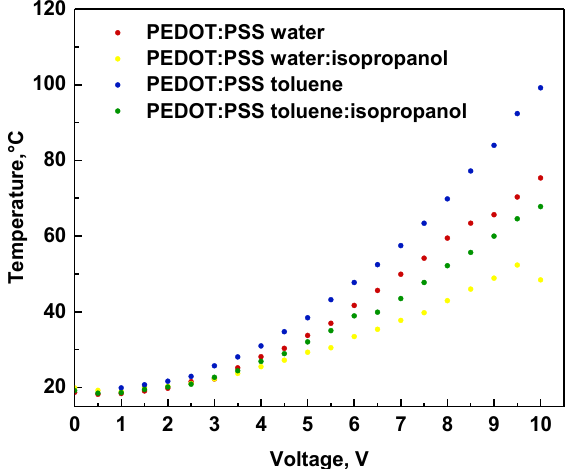
Figure 9. The correlation of temperature versus applied potential for constructed devices containing PEDOT:PSS from water, water:isopropanol, toluene, and toluene:isopropanol.